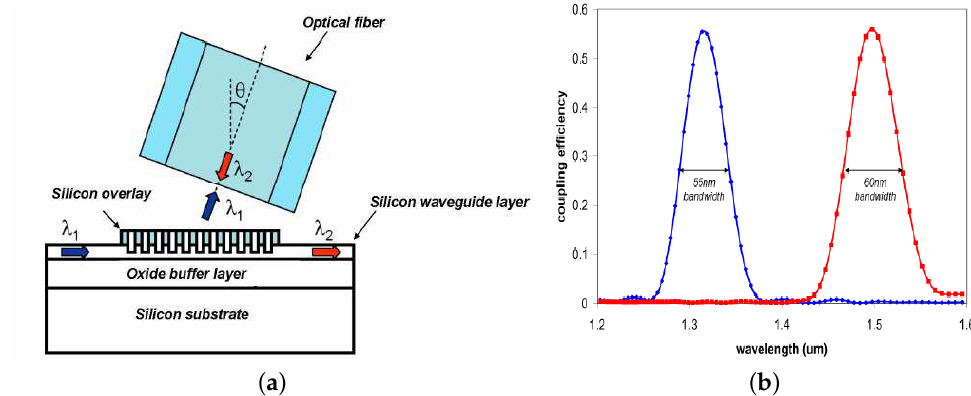
Figure 16. ( a ) Design layout of one dimensional dual band coupler with Si overlays. Blue arrow corresponds to O-band and red arrow to C-band. ( b ) Simulated coupling efficiency for optimized device at two bands (Images reprinted with permission from [57]).